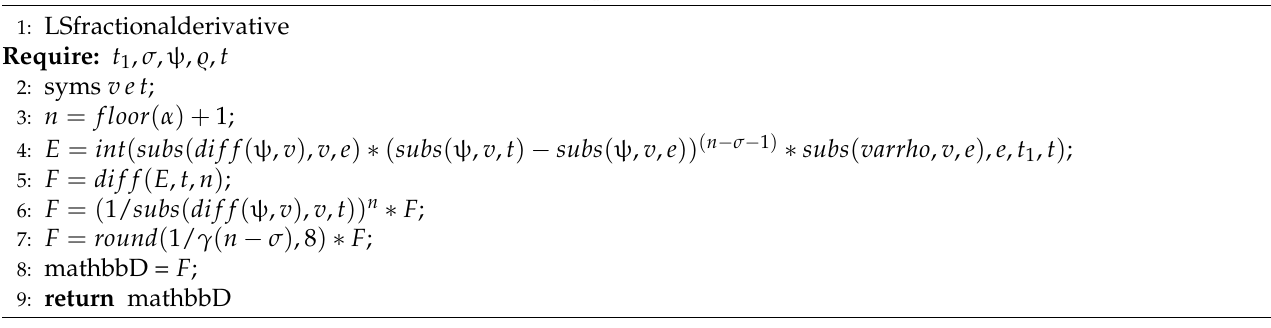
℘ ( t ) in Equation (5). t 1